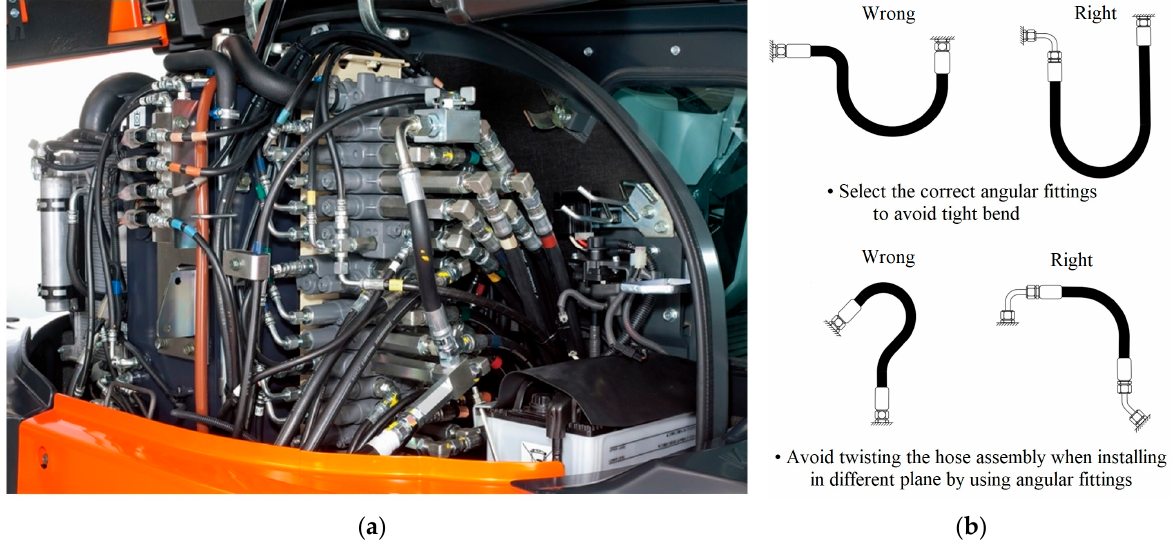
Figure 1. Composition of a typical hydraulic drive system: ( a ) part of a machine hydraulic drive system; ( b ) recommendation according to high-pressure hoses